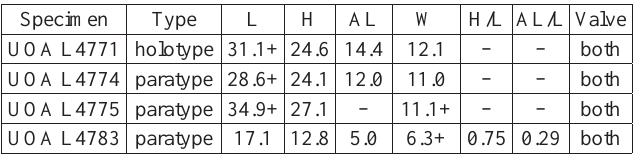
Table 2. Measurements (in mm) of Elliptiolucina sp. Abbreviations: AL, anterior length; H, height; L, length; W, width. Specimen